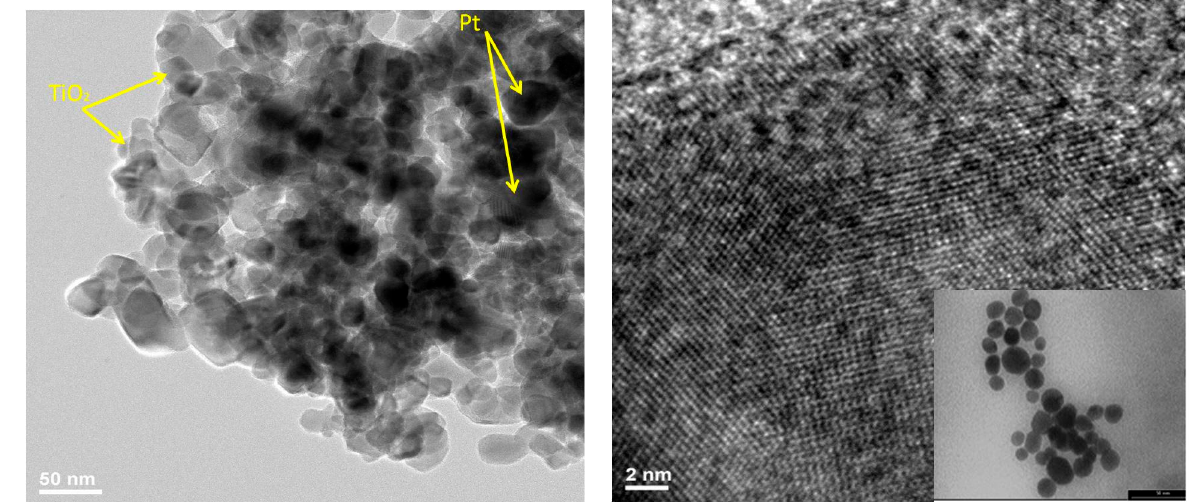
Figure 6. High magnification TEM image showing platinum nanoparticles aggregate on the TiO 2, HR-TEM images reveal {100} and {111}d-spacings, similarly reported by others for shaped Pt nanoparticles [36,37]. The images presented in Figure 6 show the characteristic sheets of the layered TiO 2 , zeolite, confirming that, although disordered, the solids maintain the intrinsic organization of the layered TiO 2 and zeolite. The EDX spectrum and mapping images were created, and the results are included in Figure 7 and Table 4, respectively. The EDX mapping (Figure 7) suggests a homogeneous distribution of Pt nanoparticles located between the anatase, rutile and aluminosilicates.